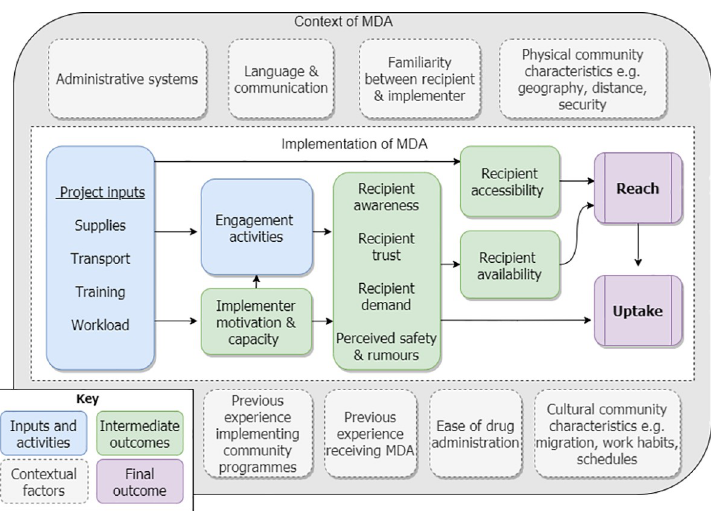
Fig 1. Conceptual framework for delivery of community-wide mass drug administration.